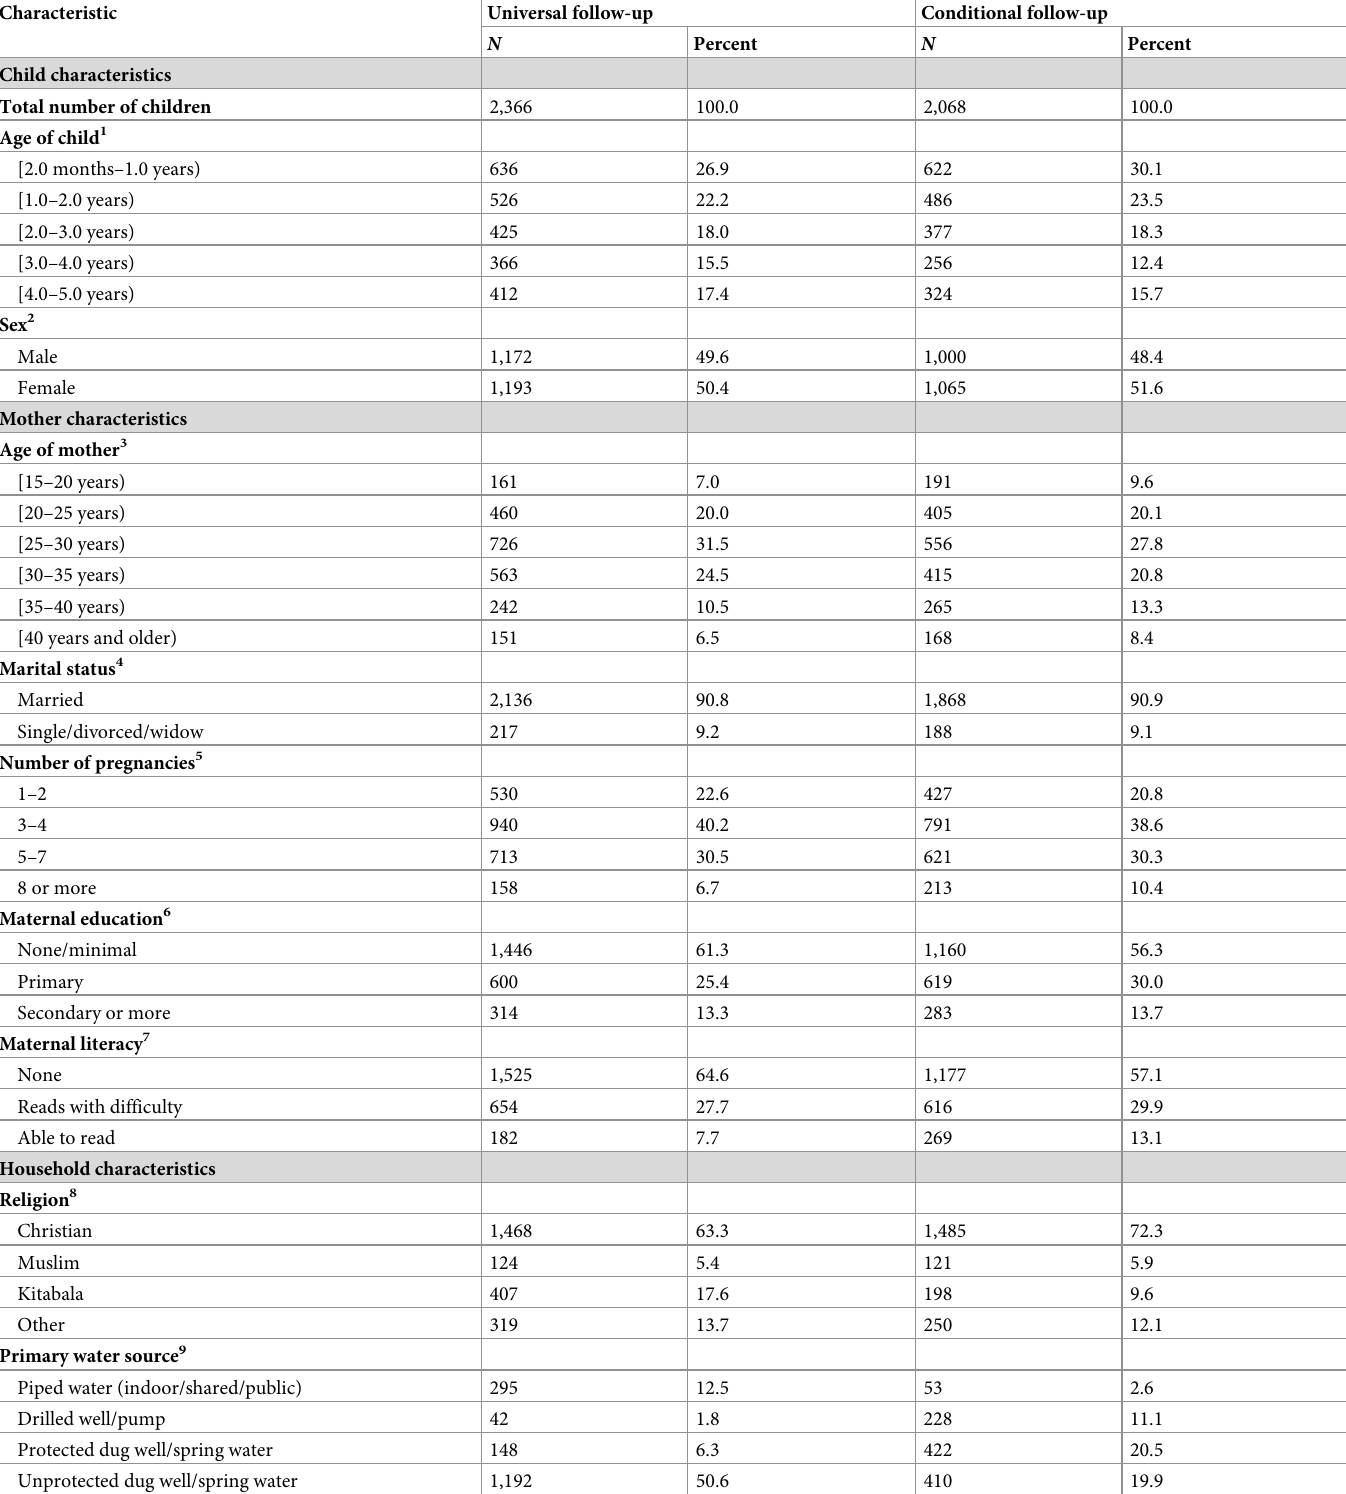
Table 1. Distribution of child, maternal, household, and CHW characteristics between universal and conditional follow-up groups.